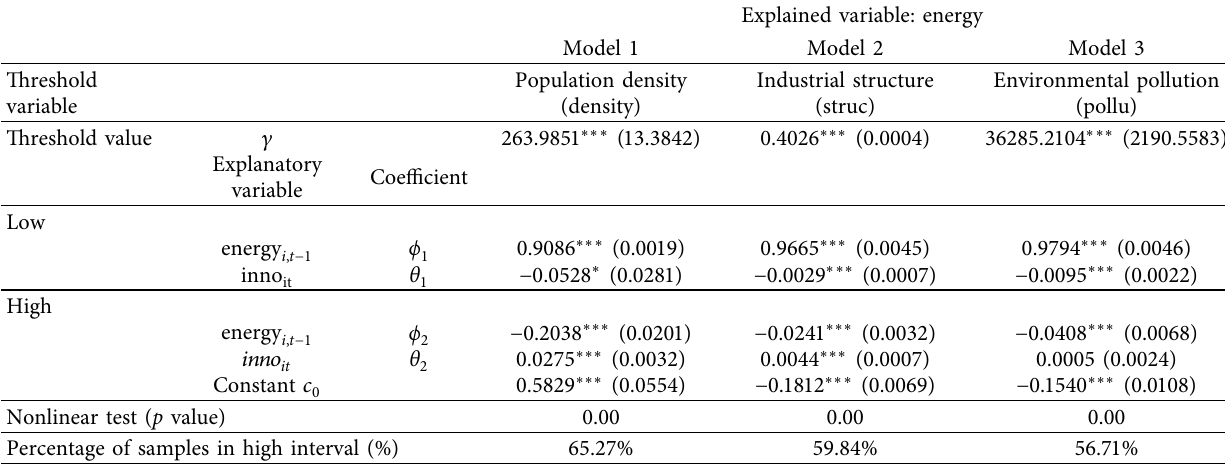
Table 7: Estimated results based on